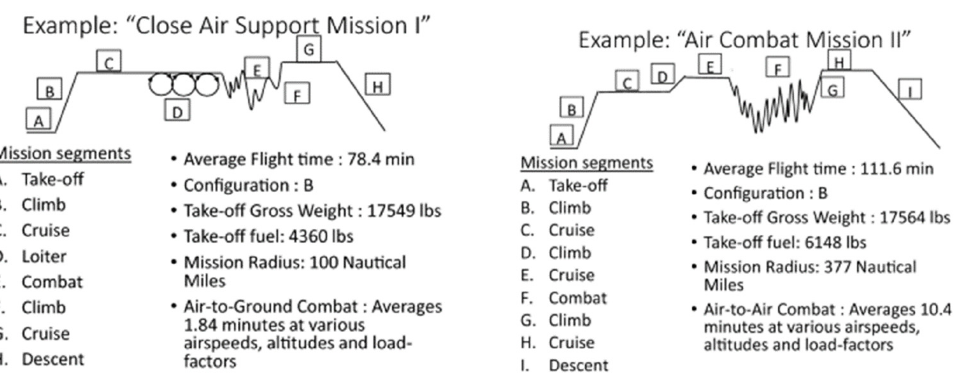
Figure 2. Representation of one mission profile [10].